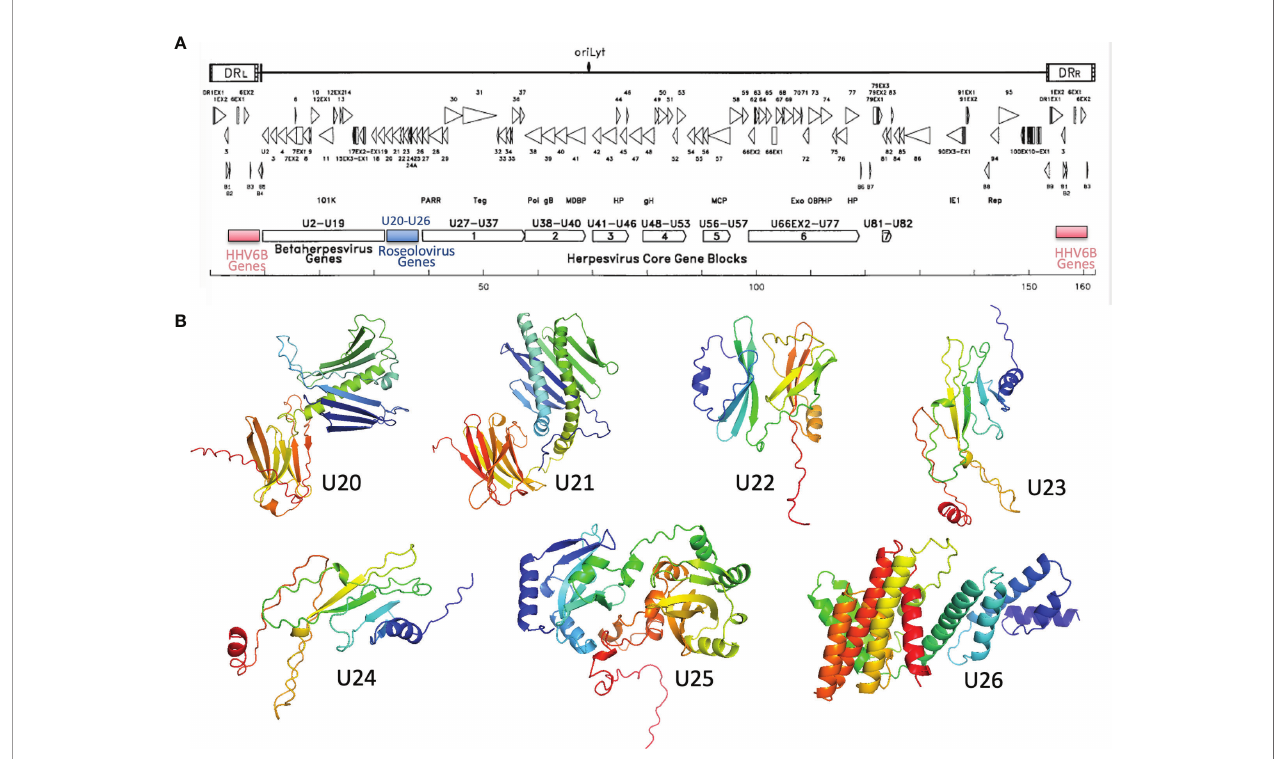
FIGURE 6 | Roseolovirus-speci fi c U20-U26 gene cluster. (A) Schematic diagram of HHV-6B gene organization, modi fi ed from (52). The U20-U26 cluster of genes speci fi c to roseolovirus is indicated in blue. (B) AlphaFold predictions for members of the HHV-6B U20-U26 gene